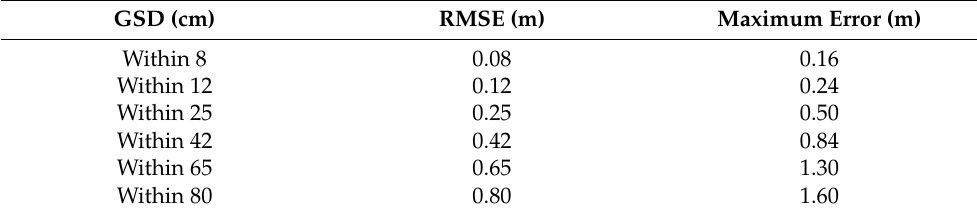
Table 5. Limitations of adjustment calculations and errors stipulated by the NGII.